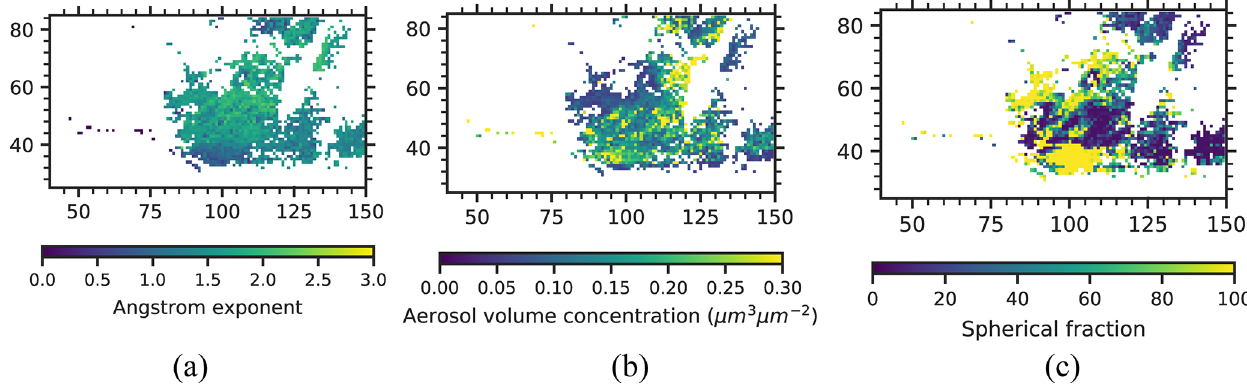
Figure 11. Map of (a) Angstrom exponent (AE), (b) aerosol volume concentration, and (c) spherical fraction (SF) of the scene shown in Fig. 9. Pixel filtering similar to the one applied for SSA, RRI, and IRI in Fig. 9 is applied to filter out bad pixels from the AE, aerosol volume concentration, and SF map. X and Y axes are the pixel